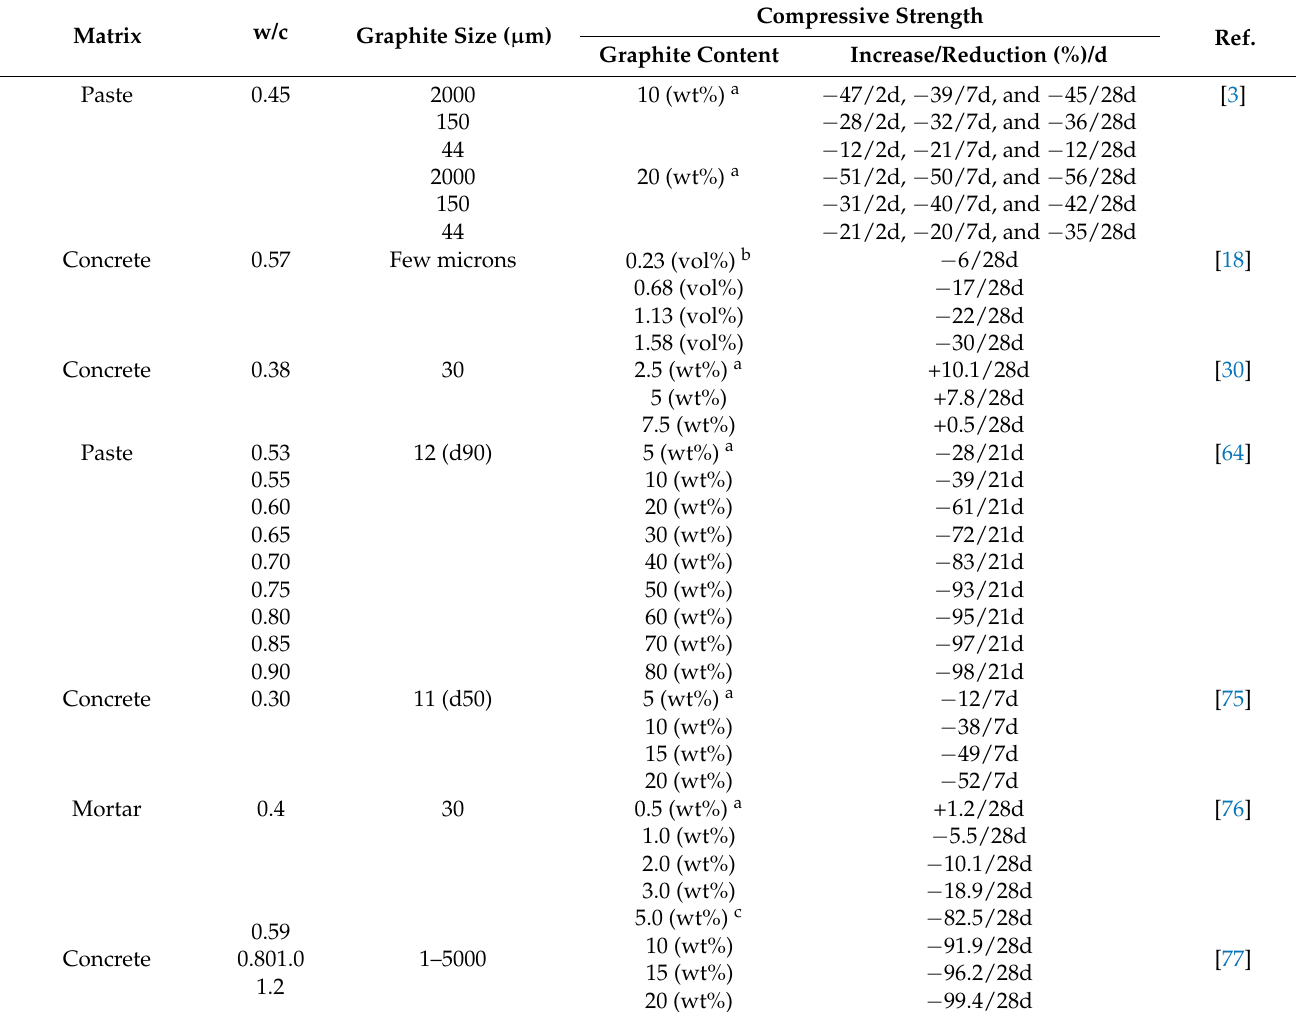
Table 3. Effects of graphite on cement-based material mechanical